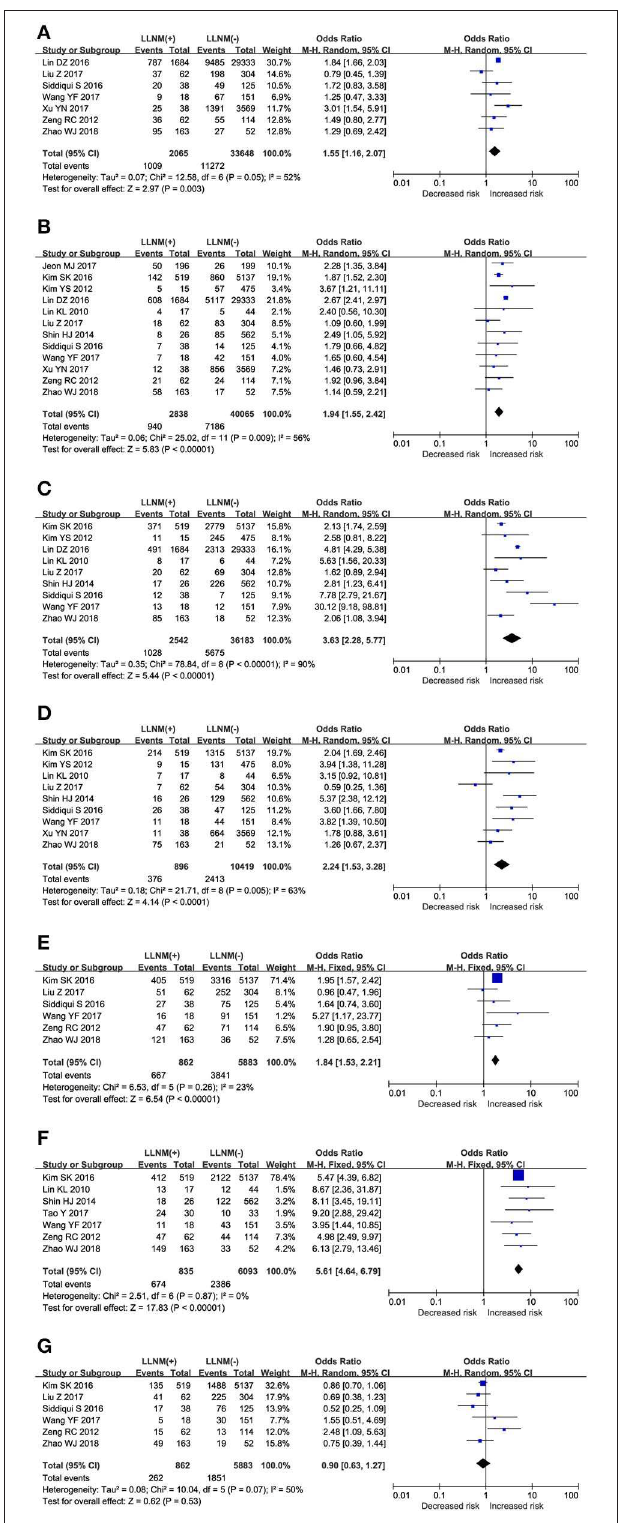
FIGURE 2 | The role of clinical risk factors for LLNM in PTMC. Forest plots for the effects of (A) Age. (B) Sex. (C) ETE. (D) Multifocal. (E) Tumor size. (F) CLNM. (G) HT.